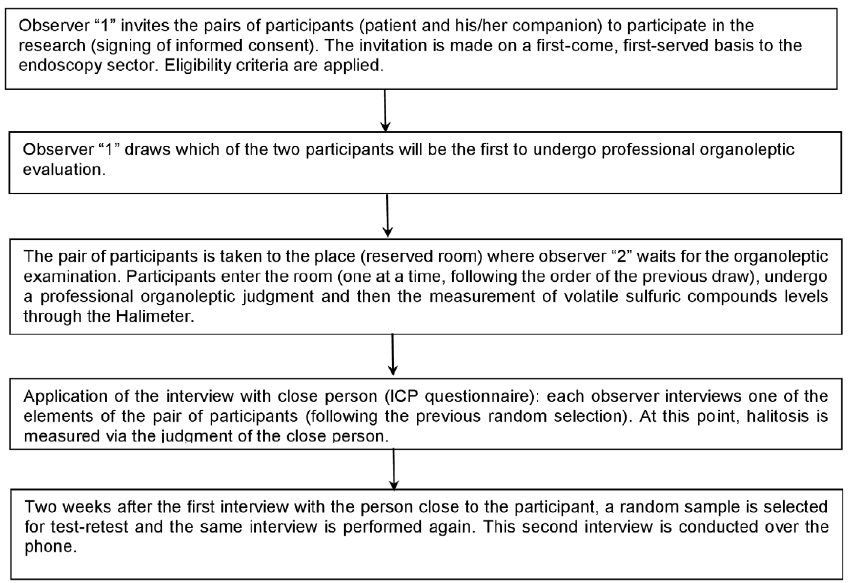
Figure 1- Phases of data